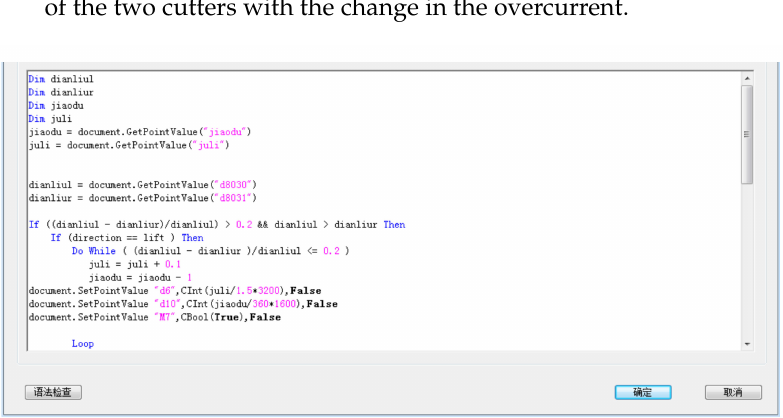
Figure A1. Periodic script programming